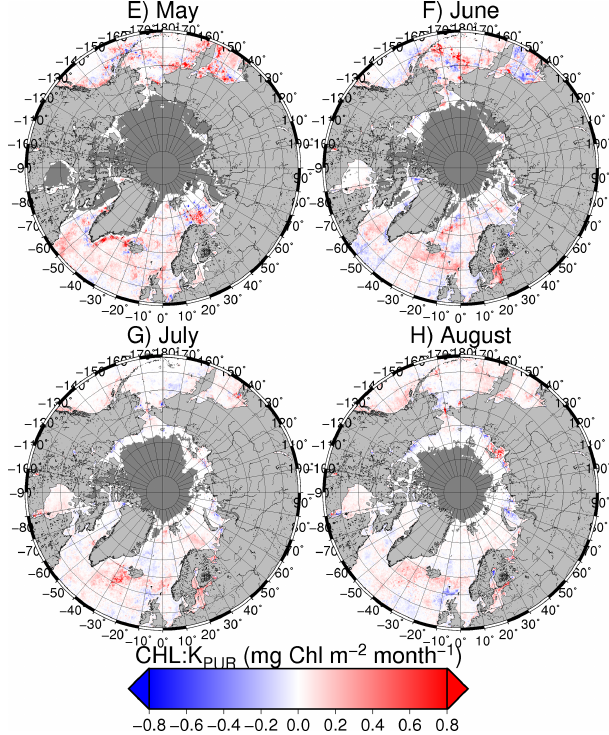
Fig. 5. (A–D) Monthly climatology of the ratio between CHL and the diffuse attenuation of PUR (CHL/K PUR ); (E–H) absolute CHL/K PUR trends calculated using the TSA, and (I–L) the stan- dardized CHL/K PUR trends (i.e. CHL/K PUR trends/climatological CHL/K PUR ·